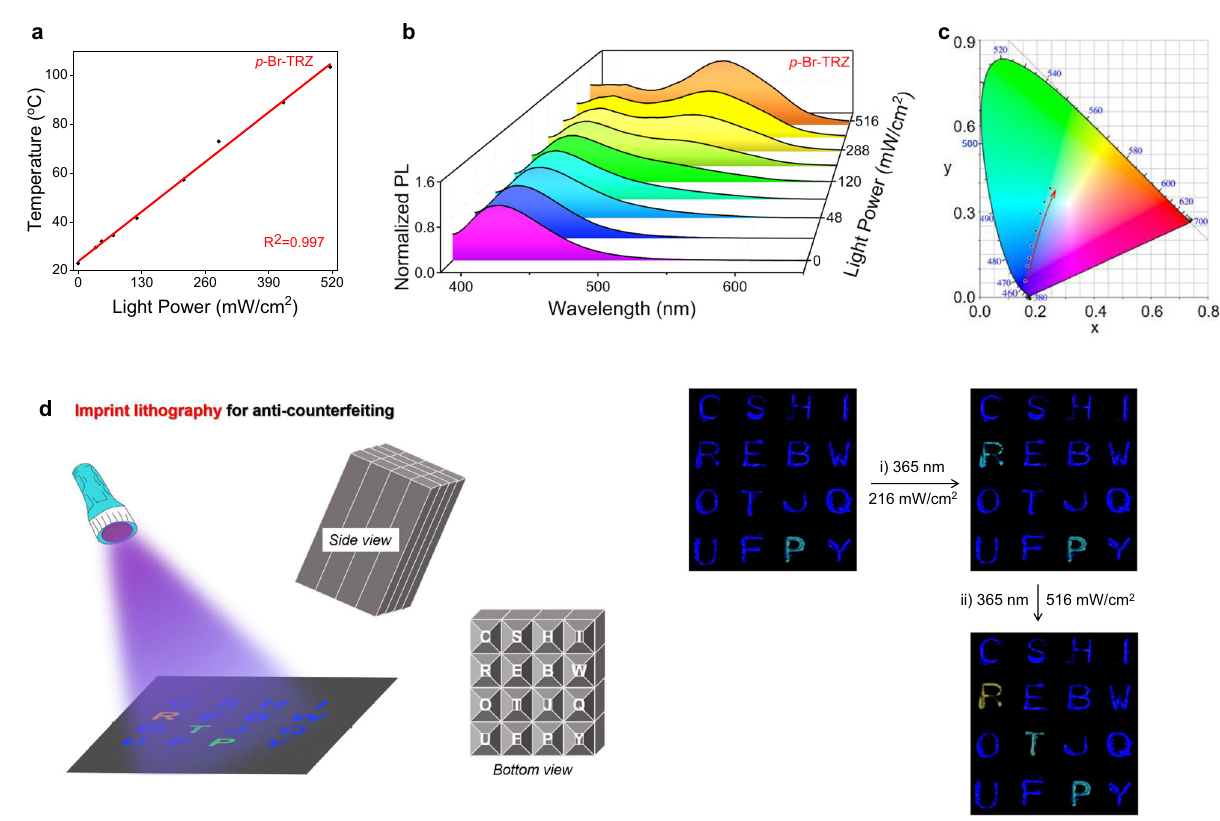
Fig. 5 Light-power-response RTP and application. a Changes in the photothermal temperature of powdered p -Br-TRZ on increasing the power of 365 nm light from 0 to 516 mW/cm 2 demonstrate a linear relationship between photothermal temperature and irradiation powder. b Three-dimensional plot of luminescence of p -Br-TRZ vs power of 365 nm light vs wavelength showing dynamics of enhancement of phosphorescence and phosphorescence/ fl uorescence intensity ratio on increasing irradiation power. c Corresponding 1931 CIE coordinate diagram of p -Br-TRZ with different power 365